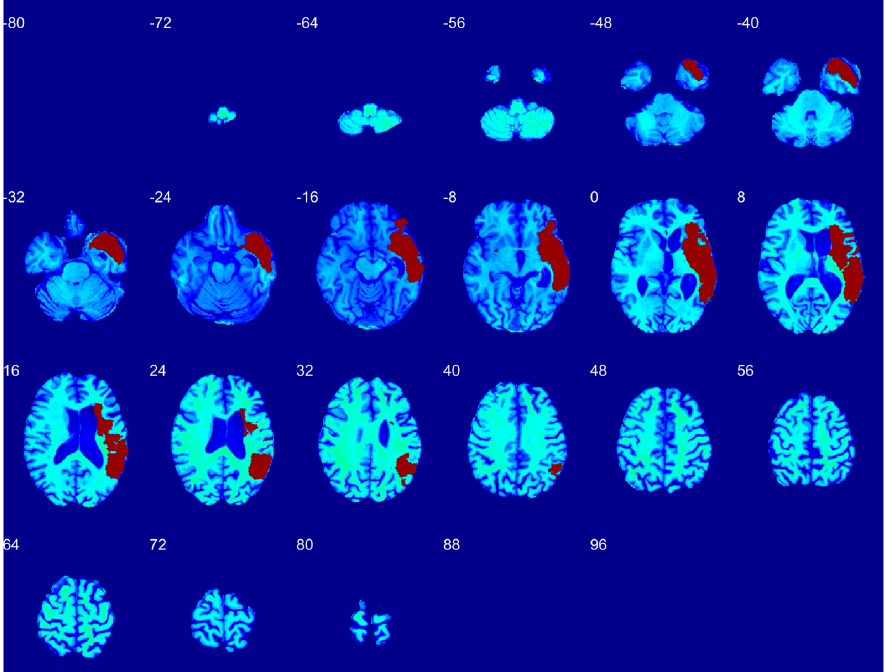
Figure 5. Sagittal sections showing automatic segmentation of left MCA stroke.